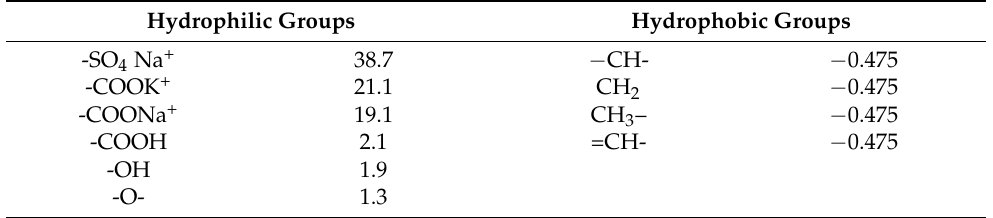
Figure 2. Graph I1/I3 = f(log(C)) for the sodium oxyacetates of CNSL ( 8 ) surfactant. Table 9. HLB of each function.